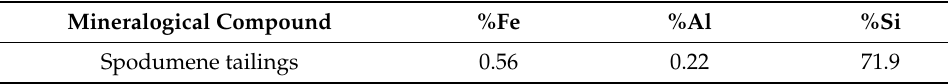
Table 2. Chemical composition of the tailings.